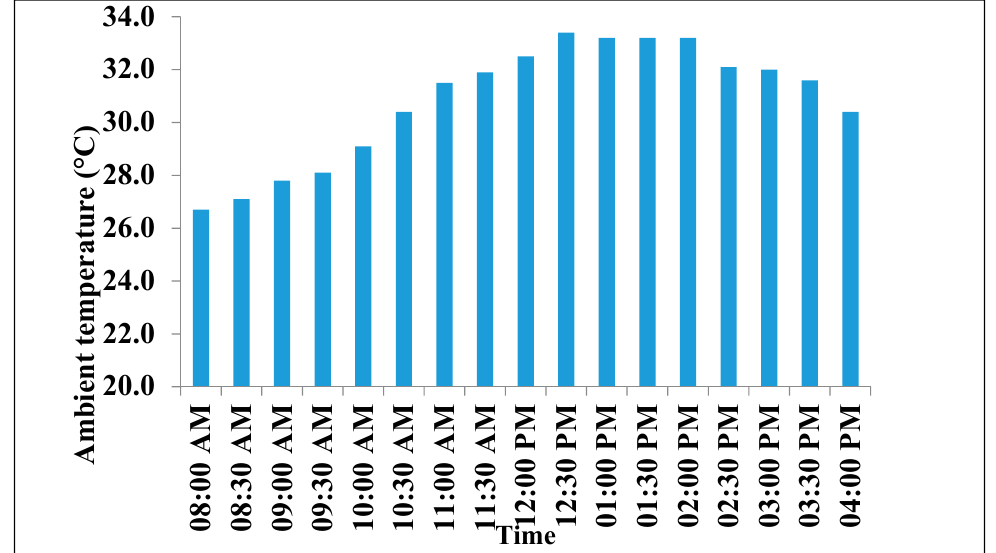
Figure 3. Variation of ambient temperature during the day time of 15 May 2017 at